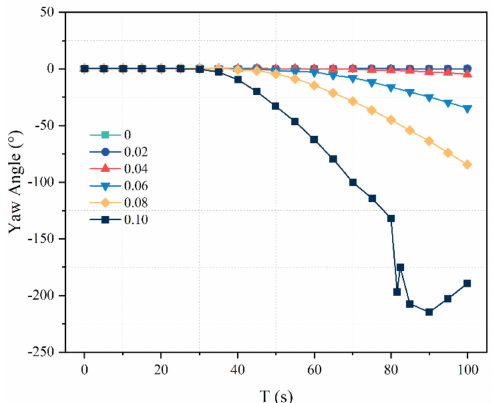
Figure 6. Yaw angles under different Munk moment coefficients.